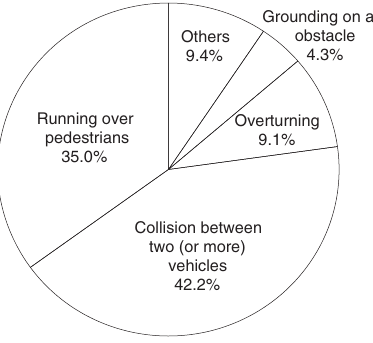
Fig. 4. The percent distribution of traffic accidents in Lithuania in 2012 (the total number of the registered